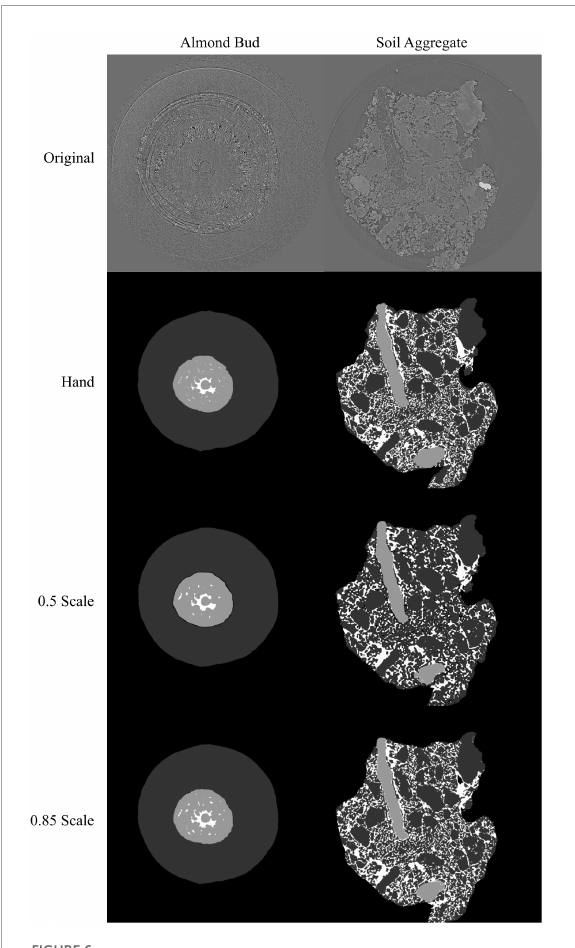
FIGURE6 Visual representation of the model outputs for an almond flower bud and a soil aggregate; top images are X-ray CT scans of the flower bud and soil aggregate; next are the hand annotated images of the scans followed by the outputs from the best performing models trained at 0.5 and 0.85 scale, respectively. For the almond flower bud, background is black, bud scales are dark gray, flower tissue is light gray, and air spaces are white. For the soil aggregate, background is black, mineral solids are dark gray, pore spaces are white, and organic matter is light